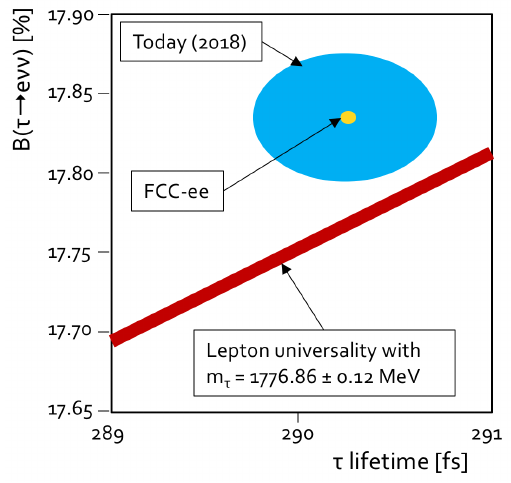
Figure 2: Branching fraction of τ → e¯ νν versus τ lifetime. The current world av- erages of the direct measurements are indicated with the blue ellipse. Suggested FCC-ee precisions are provided with the small yellow ellipse (central values have been arbitratily set to todays values). The Standard Model functional dependence of the two quantities, depending on the τ mass, is displayed by the red